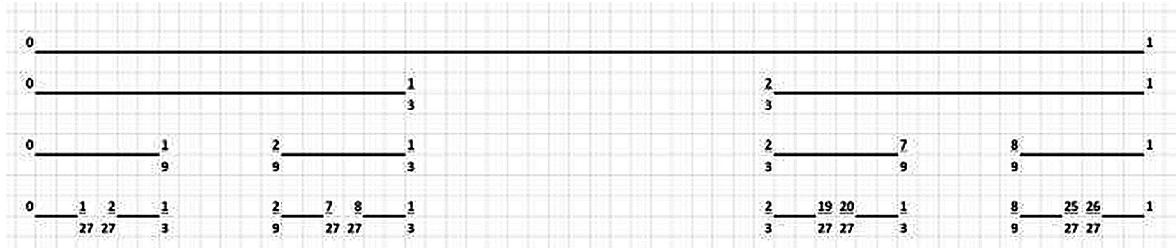
Fig. 1. Cantor’s middle third set through four